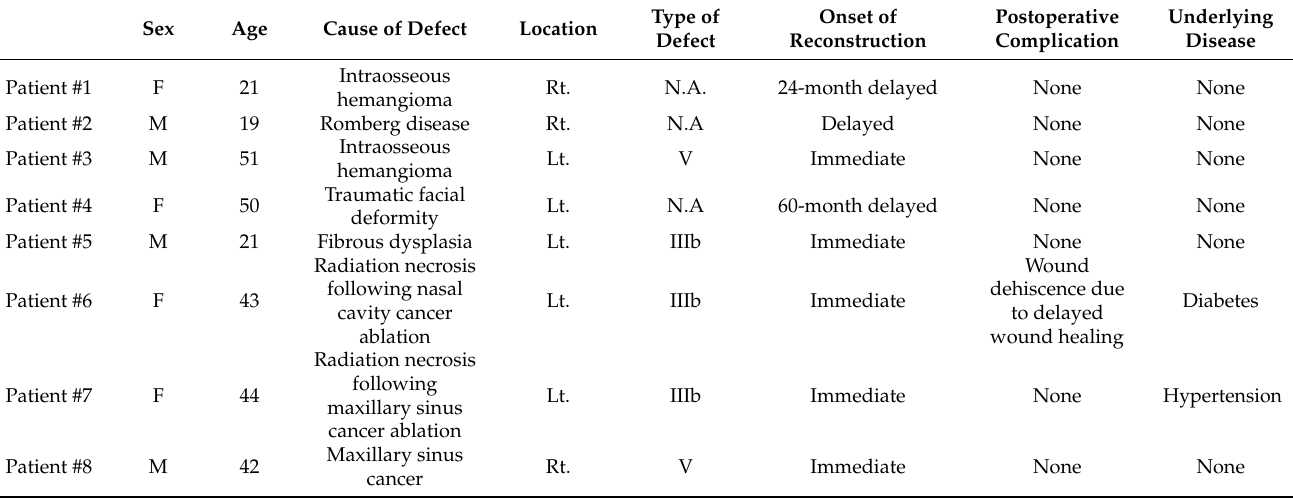
Table 1. Demographics of